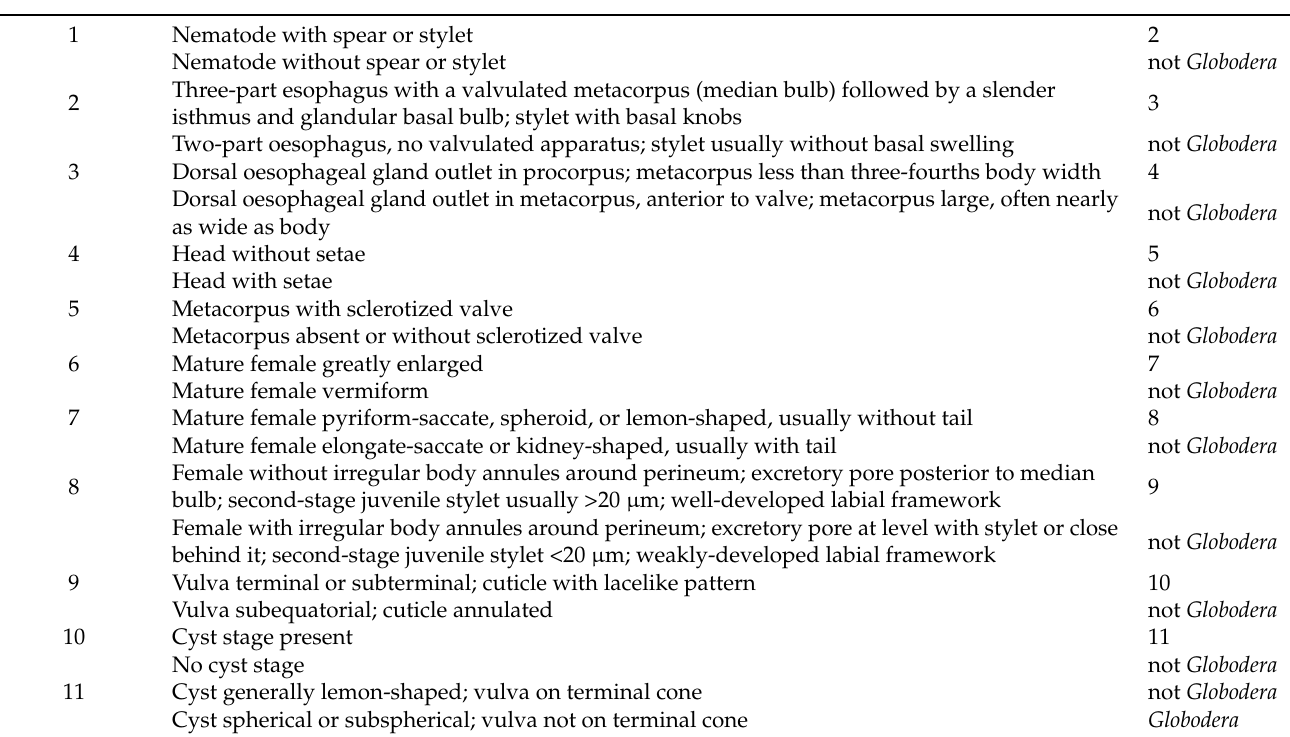
Table 1. Simplified dichotomous morphological key to genus Globodera